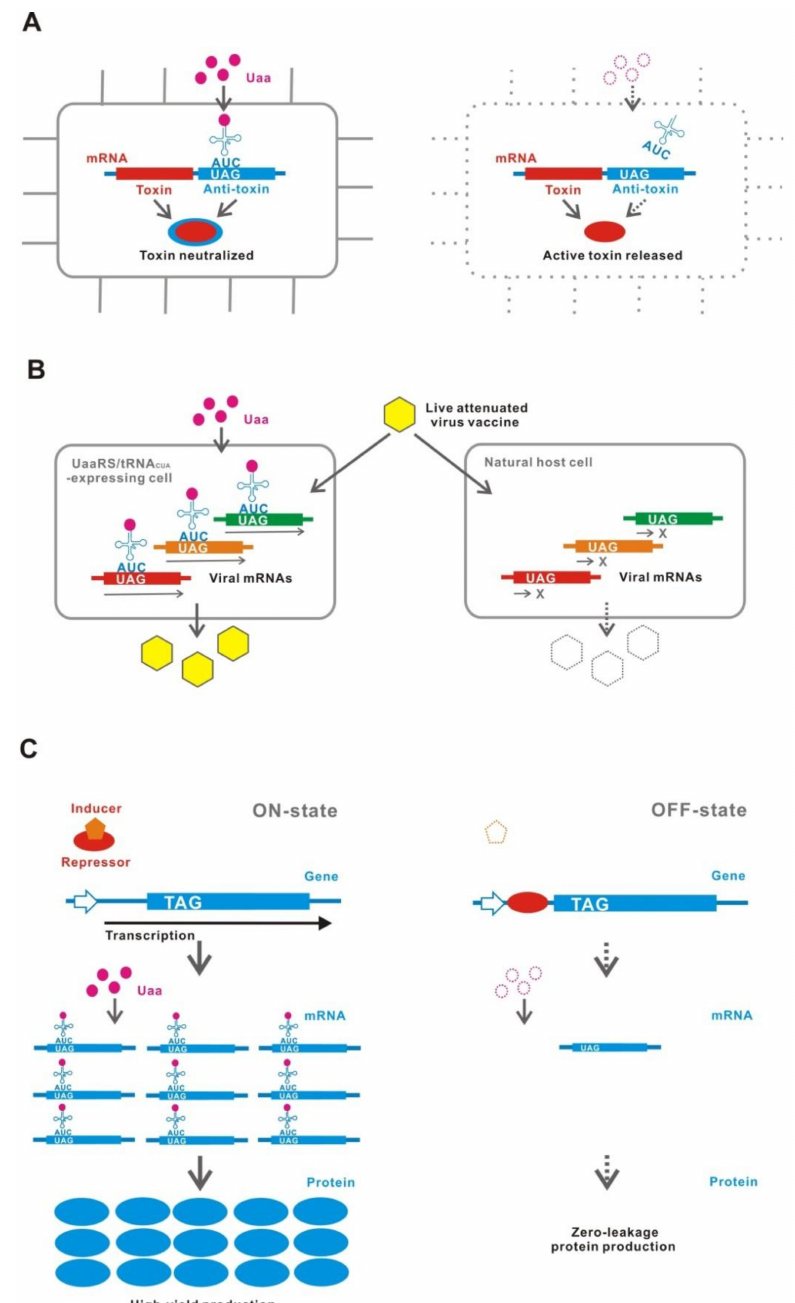
Figure 9. Applications. (A ) Biological containment. An active containment system